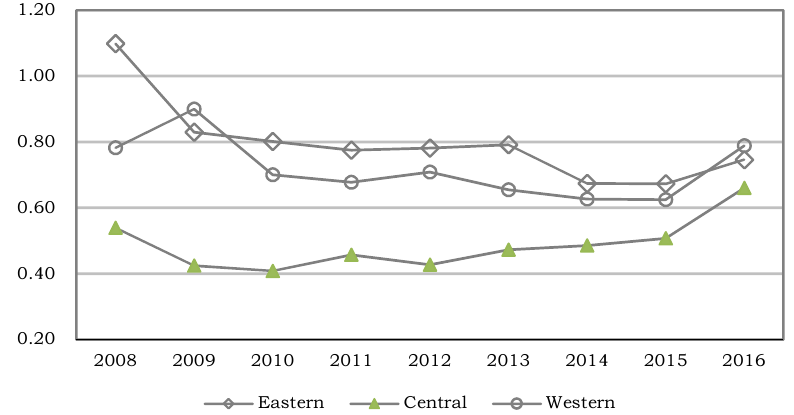
Figure 3. Average values of provincial efficiencies within each region (2008–2016).